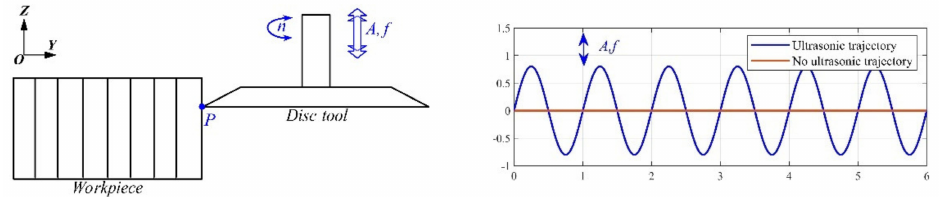
Figure 8. The RUM processing principle and disc tool trajectory.